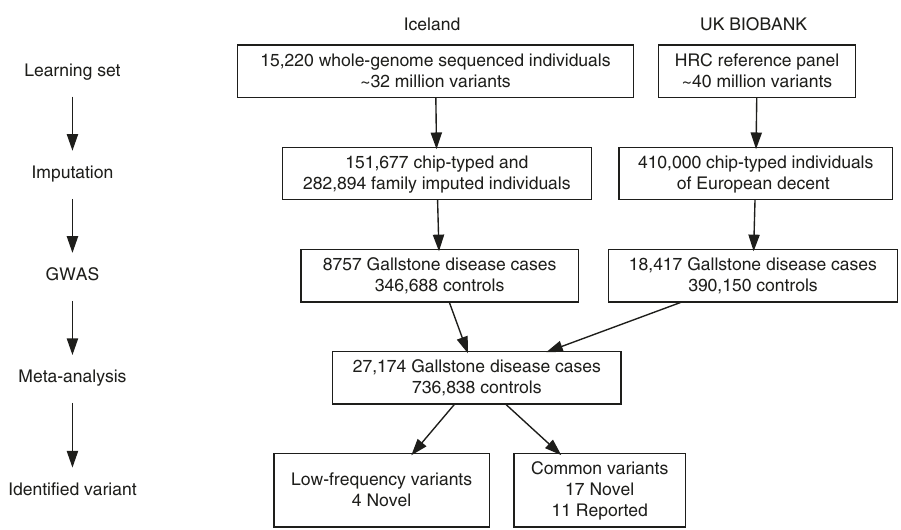
Fig. 1 A fl owchart describing the study design of the gallstone meta-analysis of Icelandic and UK Biobank data and